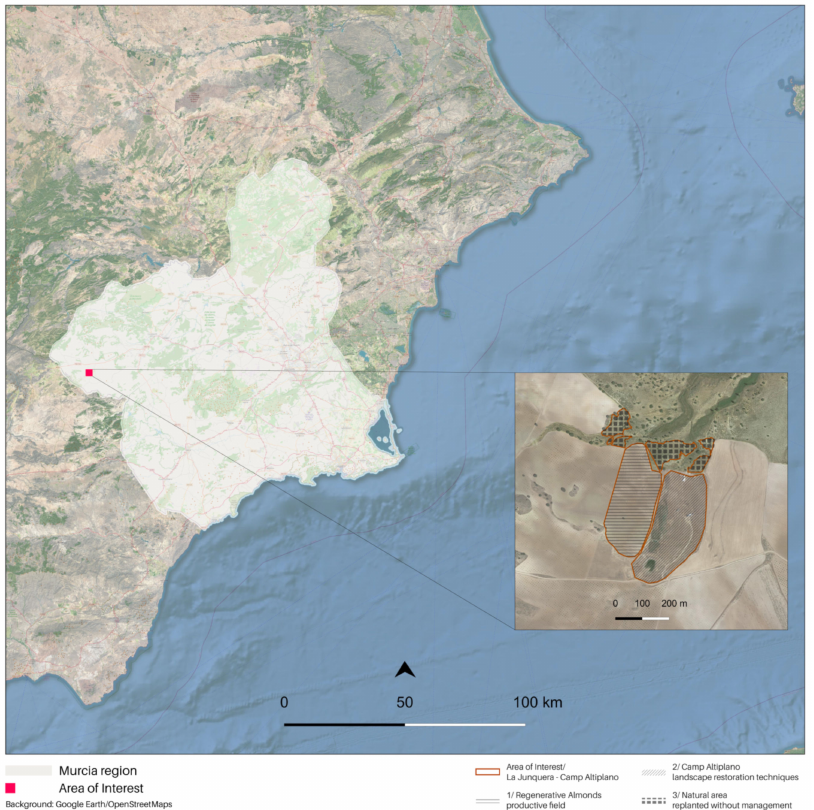
Figure 1. The study area of interest, framed in the Region de Murcia, at the top right: the area of interest specificities: ERC Camp Altiplano, where the landscape regeneration techniques are being implemented, and its proximity surroundings, the regenerative almonds on the left and, in the upper portion, the natural